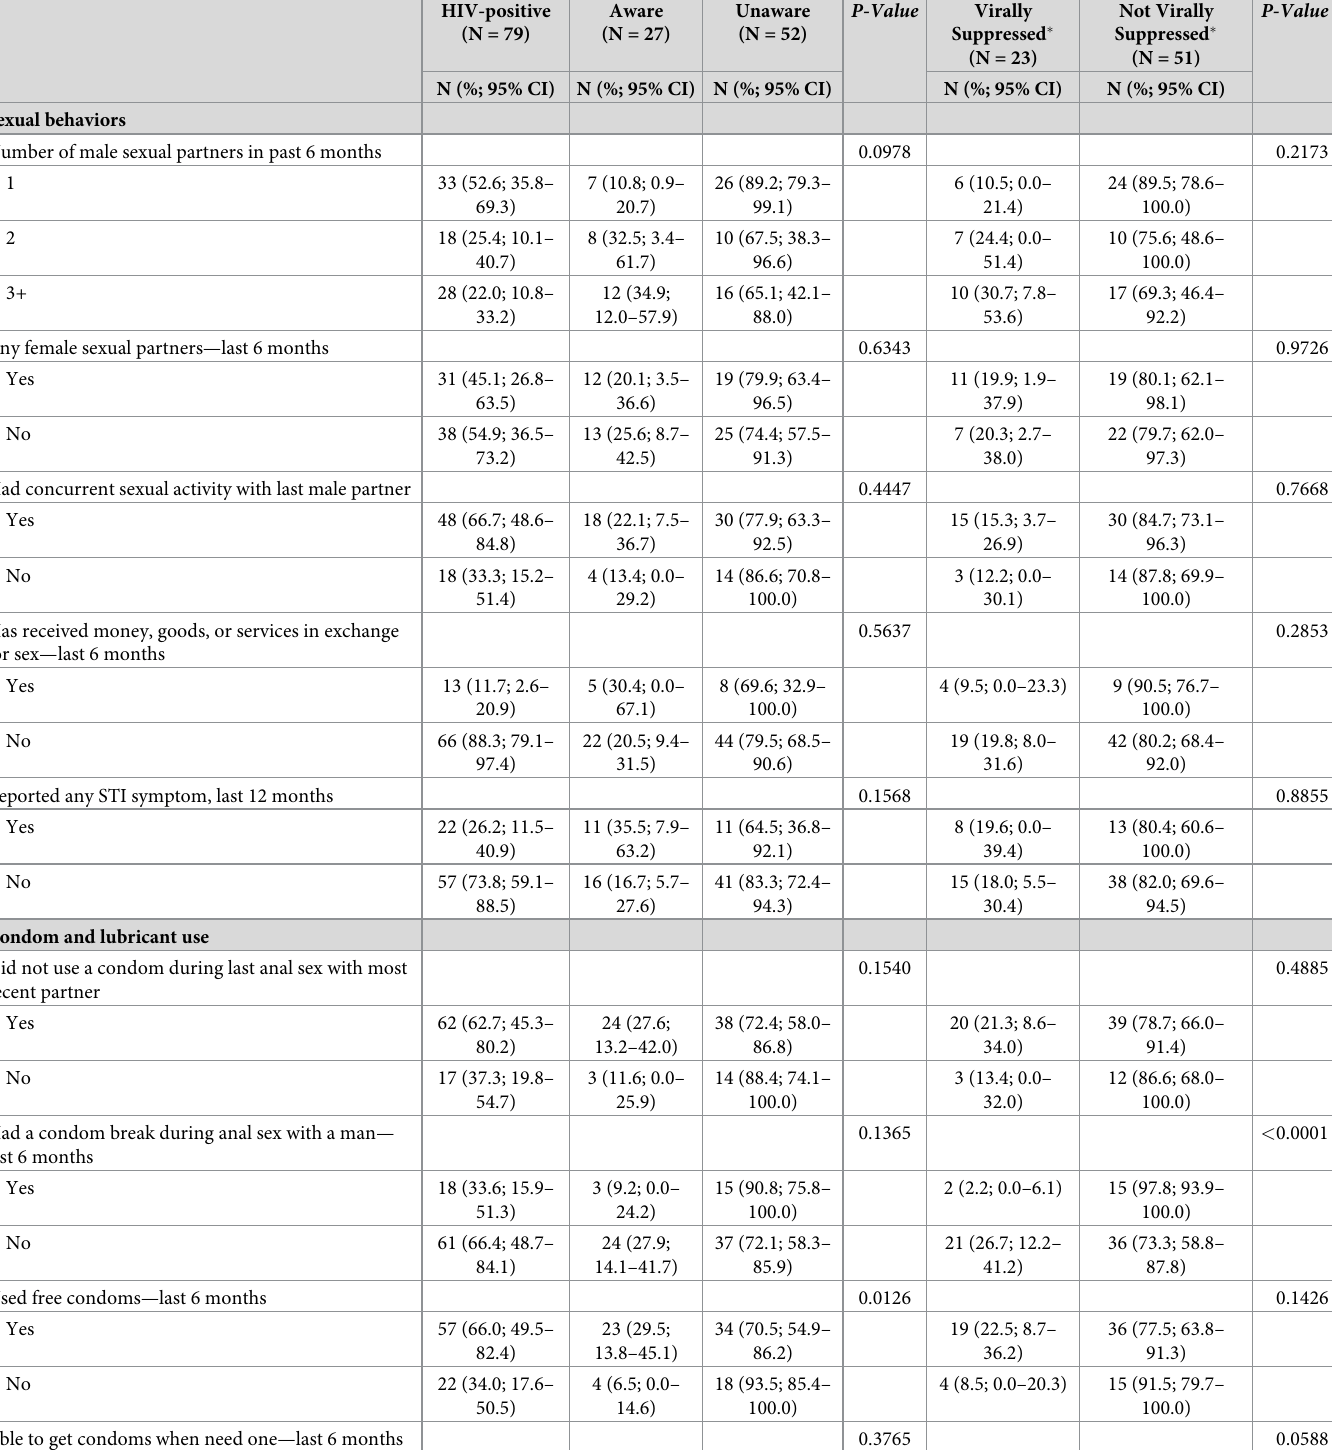
Table 2. Comparison of sexual behaviors, HIV knowledge, and condom and lubricant use among HIV-positive MSM and TGW in Bamako, Mali based on aware- ness of HIV-positive status and viral load suppression status,